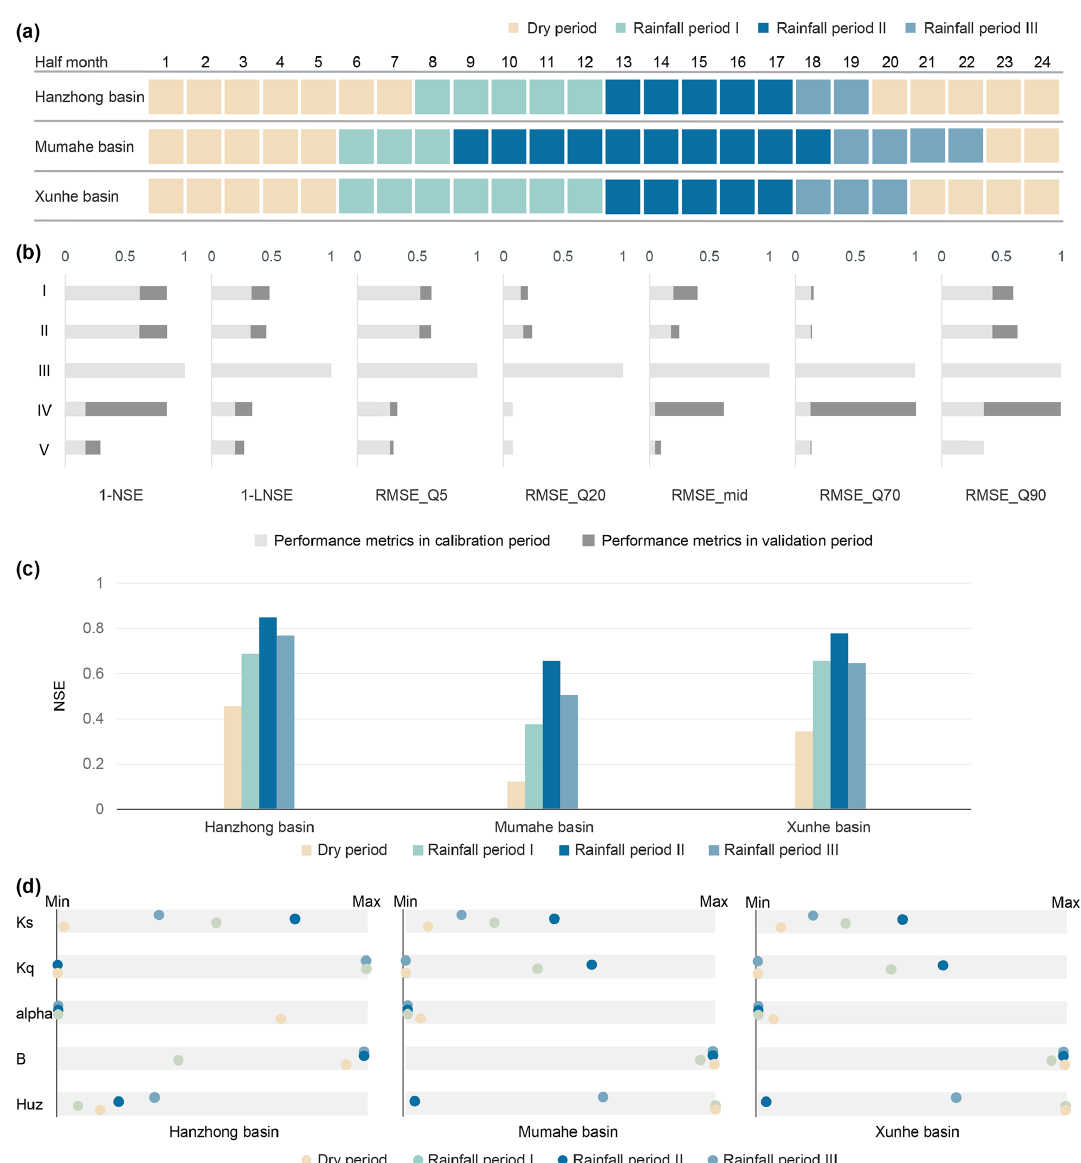
Figure 3. (a) Heat map of subperiod partition. (b) Model performance. (c) Simulation performance in four subperiods of the calibration period. (d) Seasonal dynamic parameter